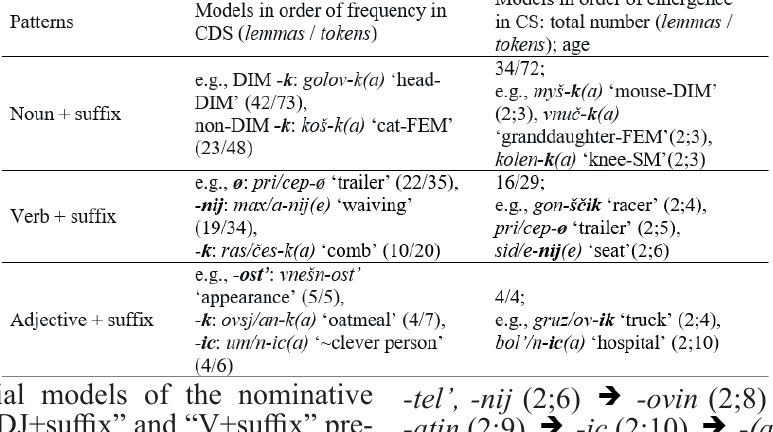
Table 5. Availability of nominal derivatives and their acquisition